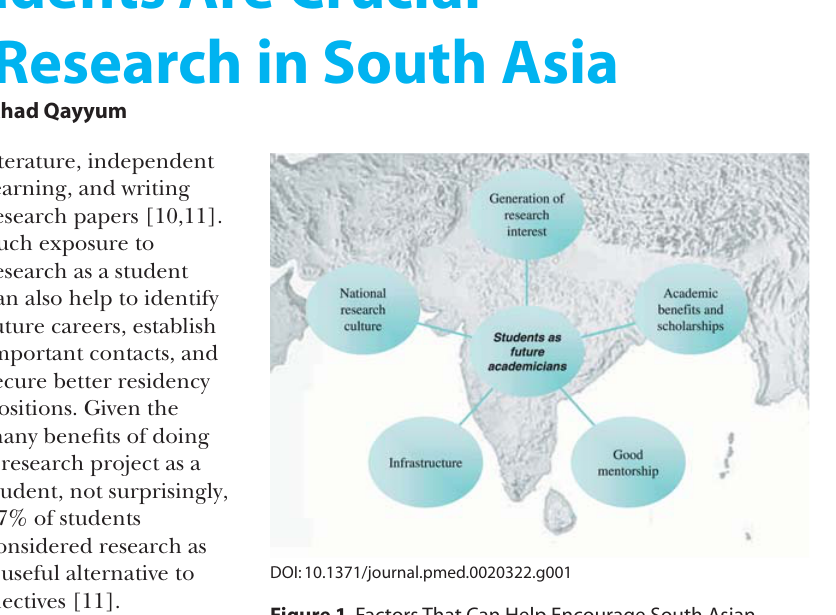
Figure 1. Factors That Can Help Encourage South Asian Medical Students to Choose a Career in Academic